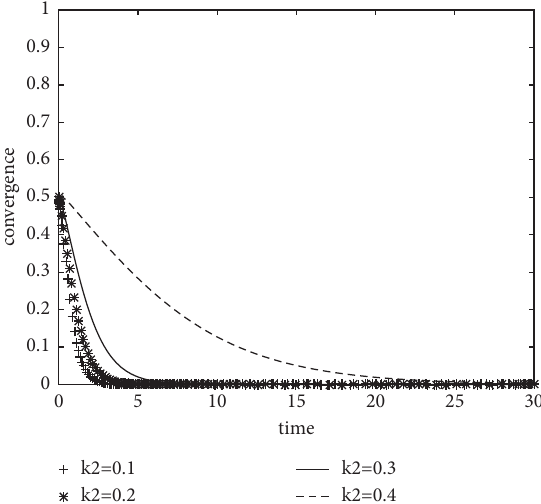
Figure 9: Impact of changing K